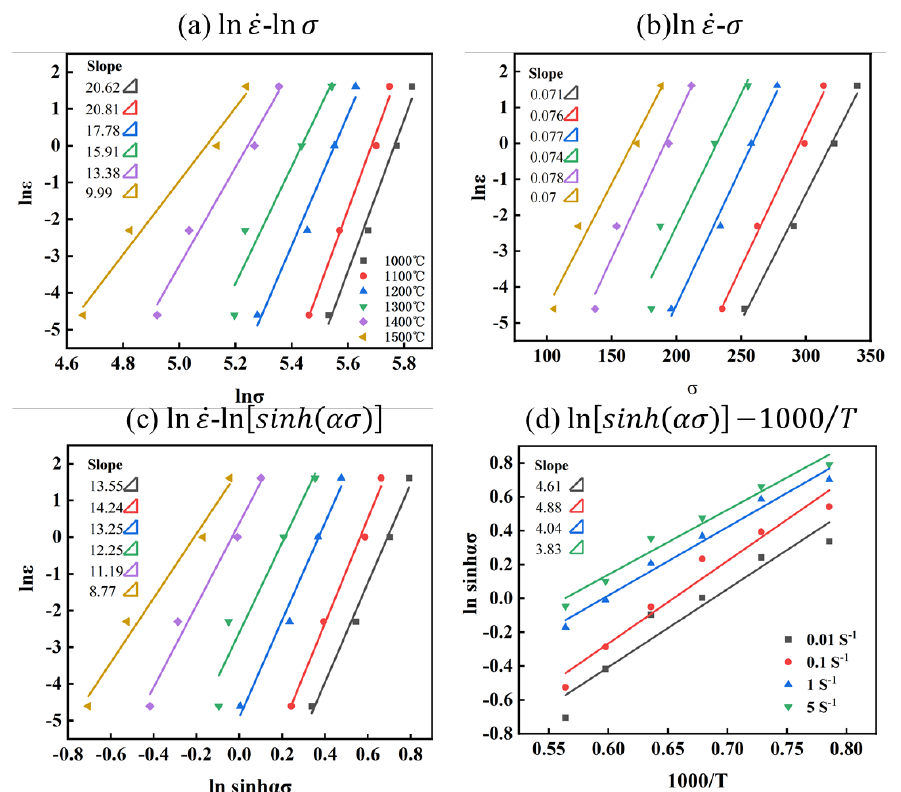
. . ε − ln σ , ( b ) ln ε − σ ,